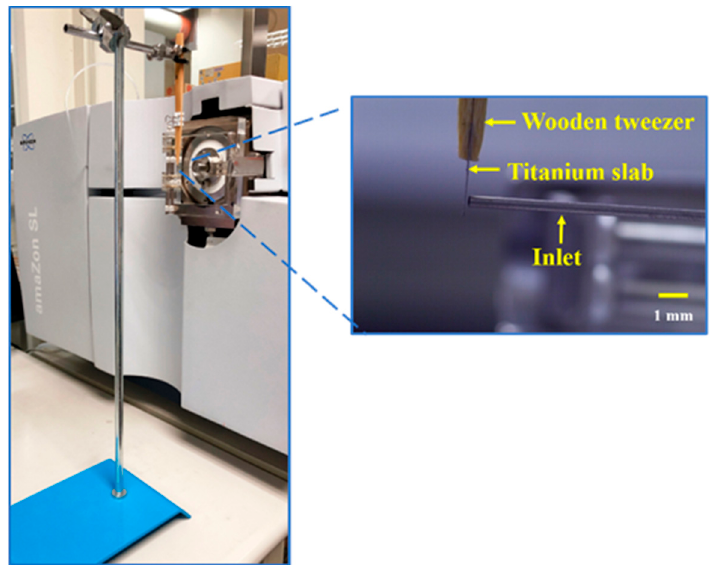
Figure 1. Photograph of the titanium slab-based ASAI–MS setup .